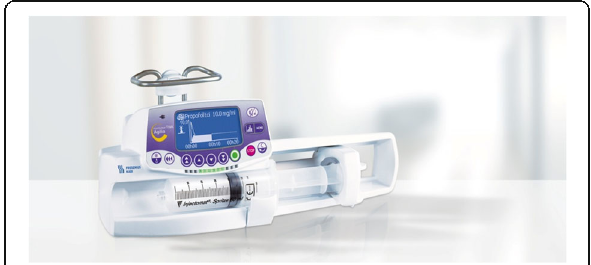
Fig. 1 Injectomat TIVA Agilia®, Fresenius Kabi,